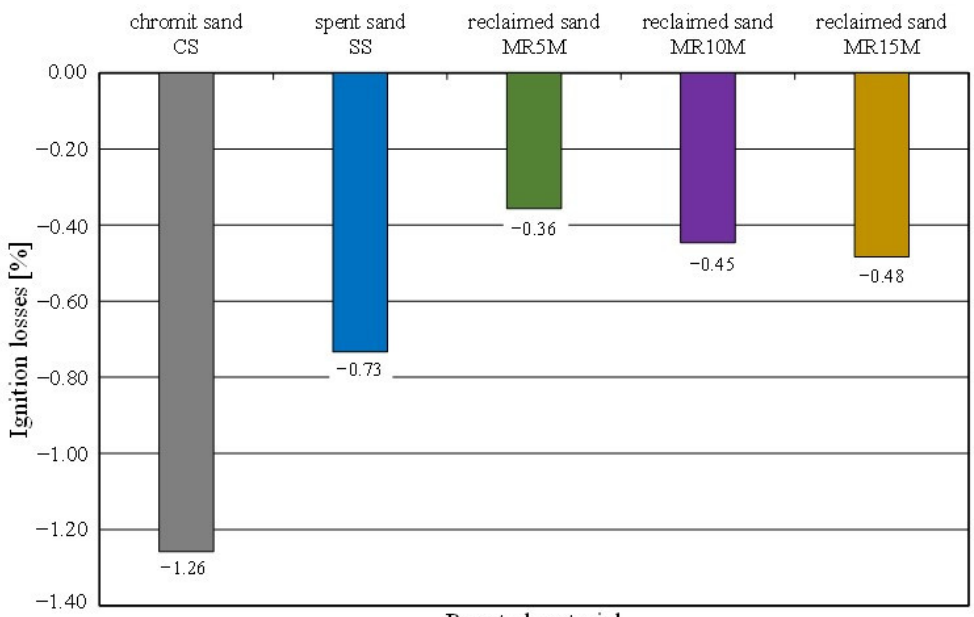
Figure 13. Ignition losses of tested